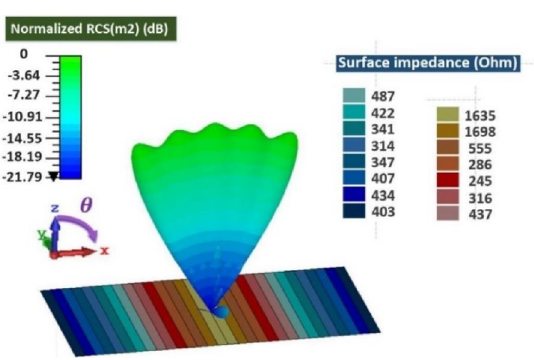
Figure 6. Generation of one-dimensional flat-top pattern in the elevation direction using surface impedance ribbons.